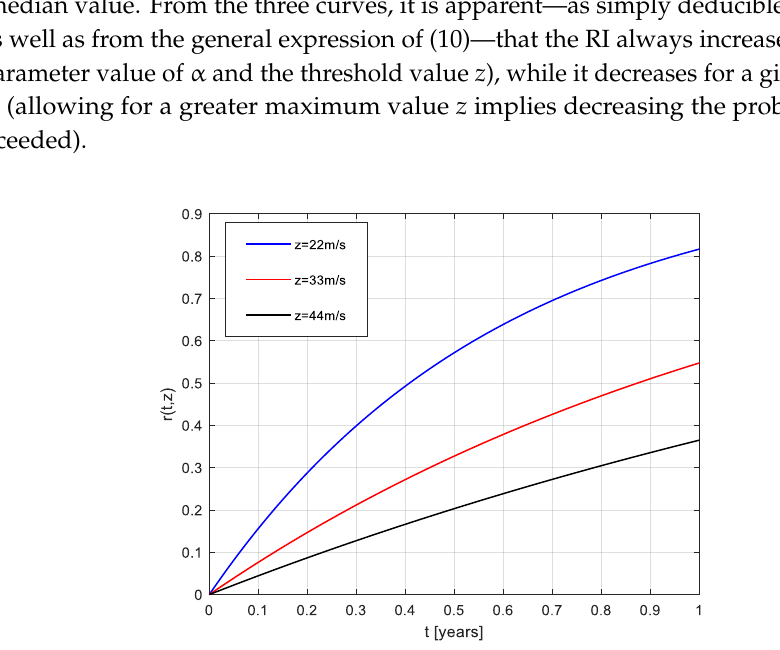
Figure 2. The risk index (RI), r ( t , z ), vs. time under an inverse Rayleigh distribution (IRD) model for three different threshold value z in m/s.